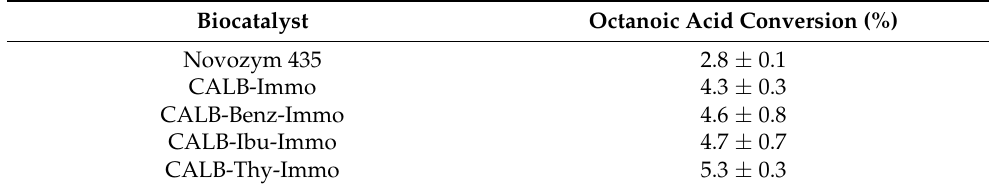
Table 3. Esterification of thymol and octanoic acid using immobilized lipase. Reaction conditions: 2 mmol of octanoic acid, 2 mmol of thymol, 15% biocatalyst (with respect to the mass of acid), 50 ◦ C, and 24 h of